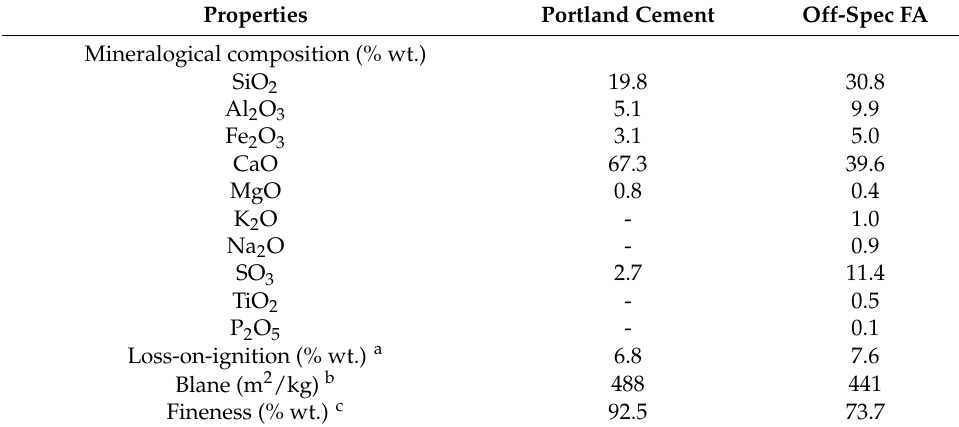
Table 1. Characteristics of Portland cement and FA used in the current study.